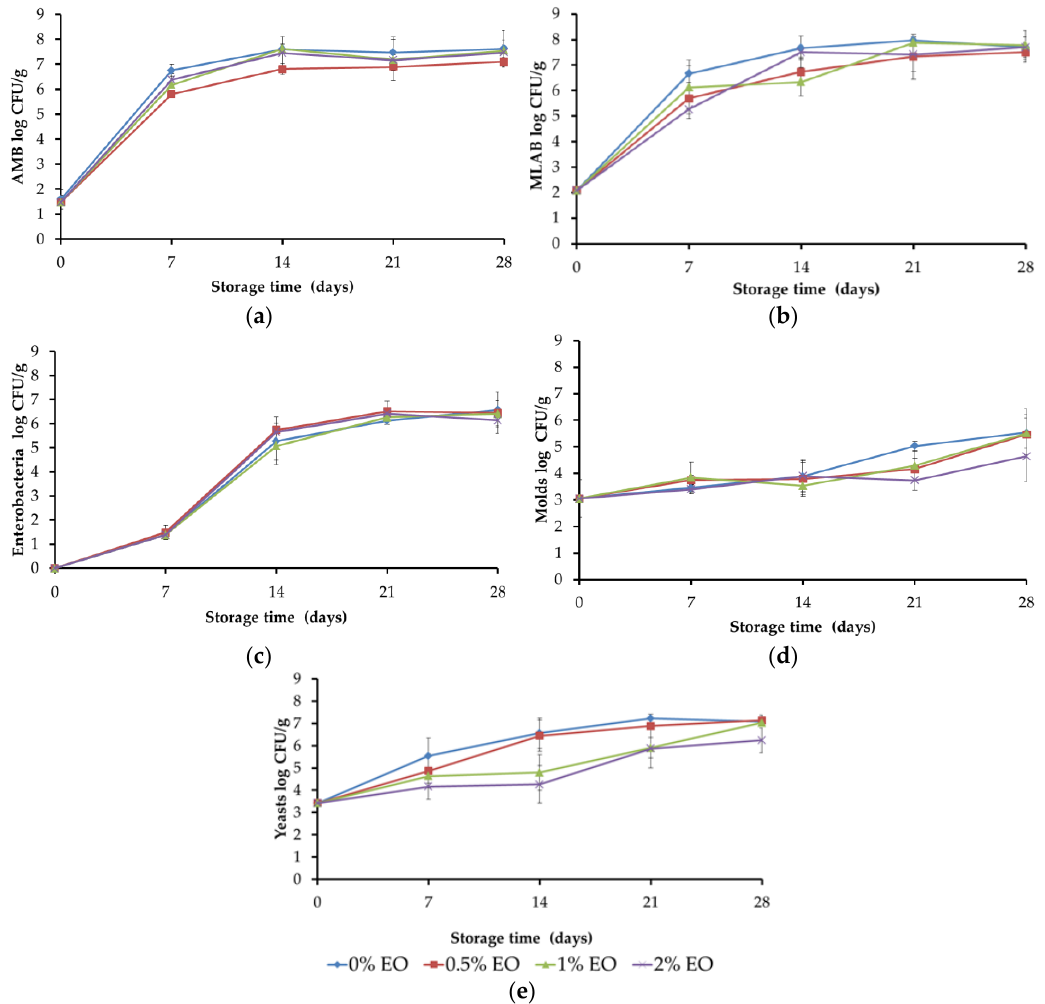
Figure 3. Evolution of ( a ) Aerobic Mesophilic Bacteria (AMB); ( b ) Mesophilic Lactic Acid Bacteria (MLAB); ( c ) Enterobacteria; ( d ) mold and ( e ) yeast counts in RTE meat packaged during refrigerated storage (0% EO: control films; 0.5% EO: films with 0.5% thyme essential oil; 1% EO: films with 1% thyme essential oil; 2% EO: films with 2% thyme essential oil).